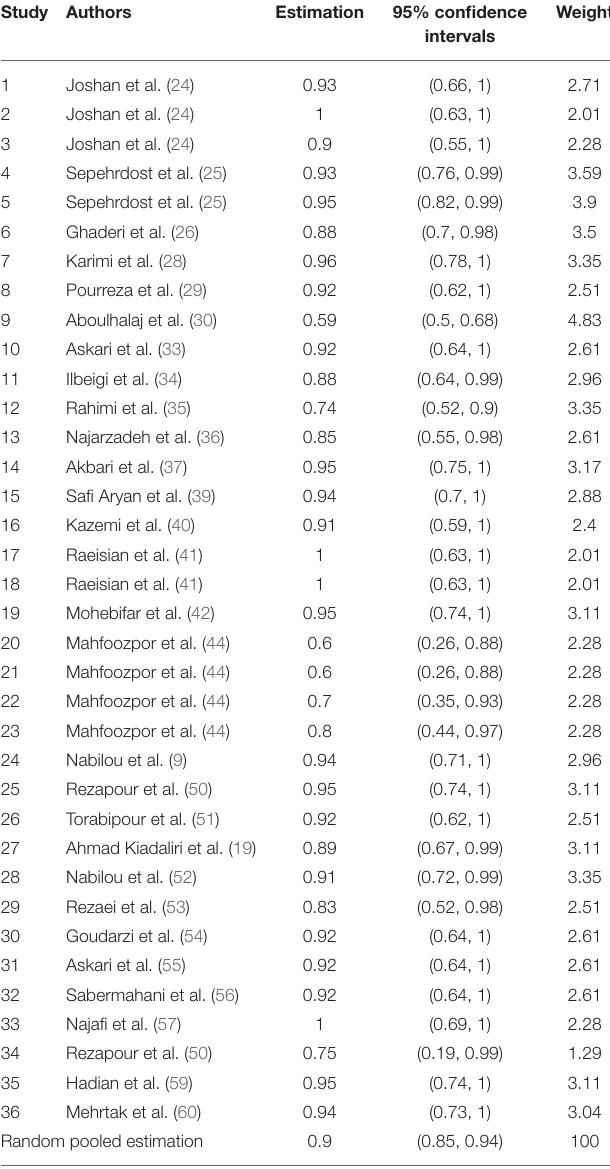
TABLE 4 | The results of pool estimation for managerial efficiency among Iranian hospitals.